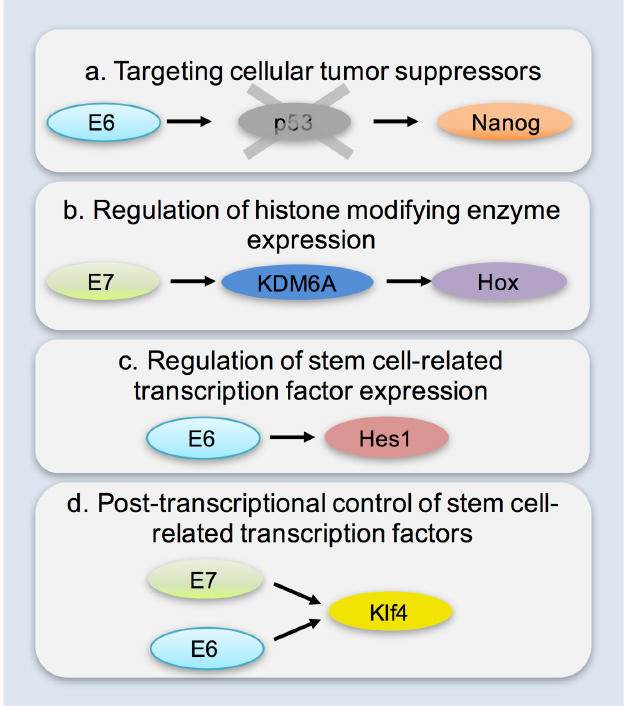
Figure 1. Potential mechanisms through which papillomavirus infection may contribute to the development of stem-like cells and cancer stem cells. ( a ) Targeting cellular tumor suppressors for